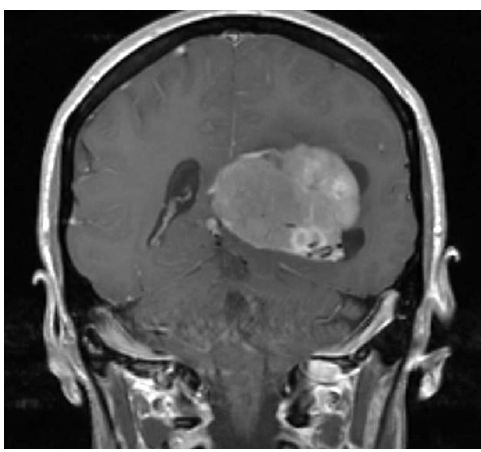
Figure 1. Pre-operative magnetic resonance imaging (MRI) demonstrates a large meningioma in the atrium of the left lateral ventricle.